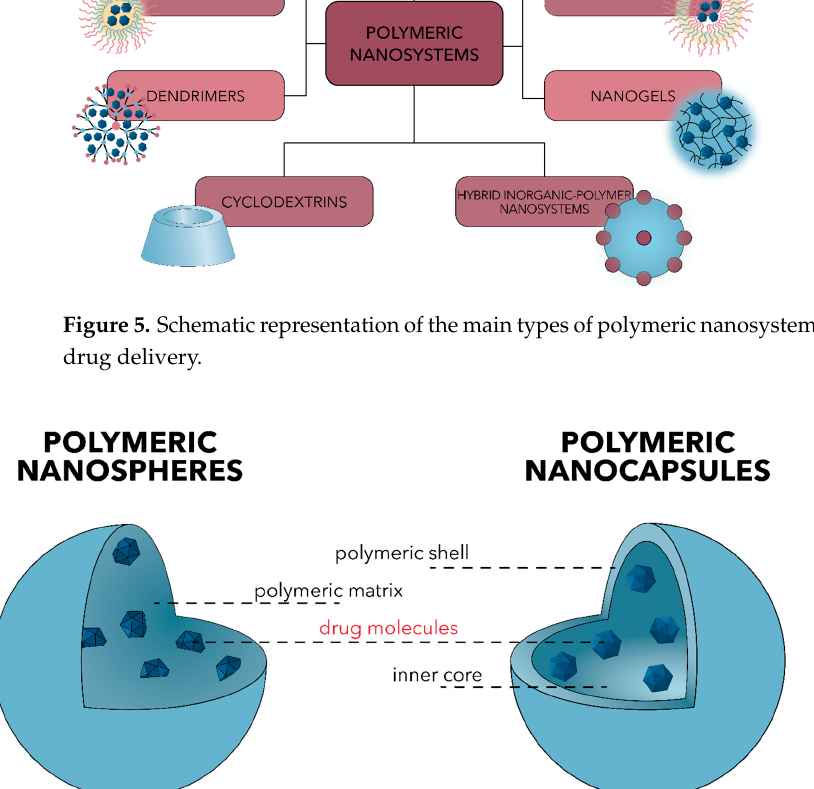
Figure 5. Schematic representation of the main types of polymeric nanosystems used for antimicrobial drug delivery.